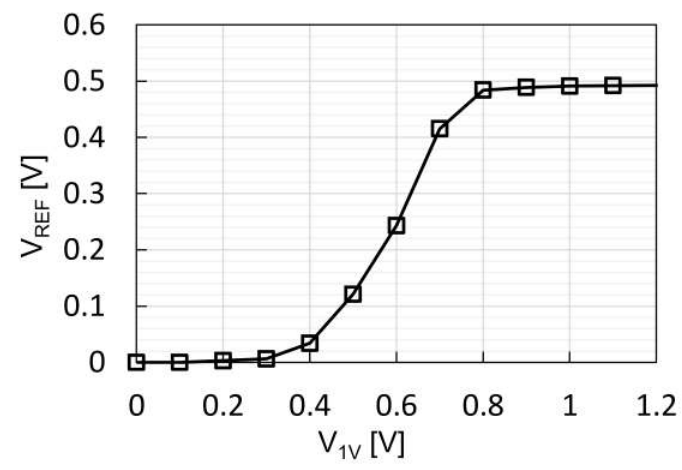
Figure 6. V REF vs. V DD .